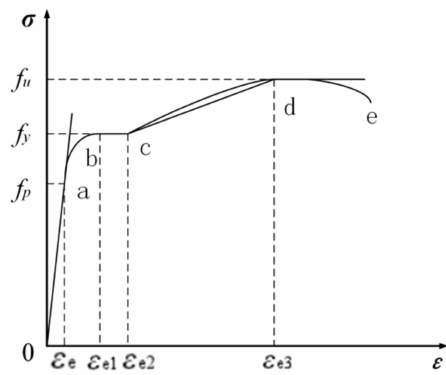
Figure 6. Stress–strain curve of carbon